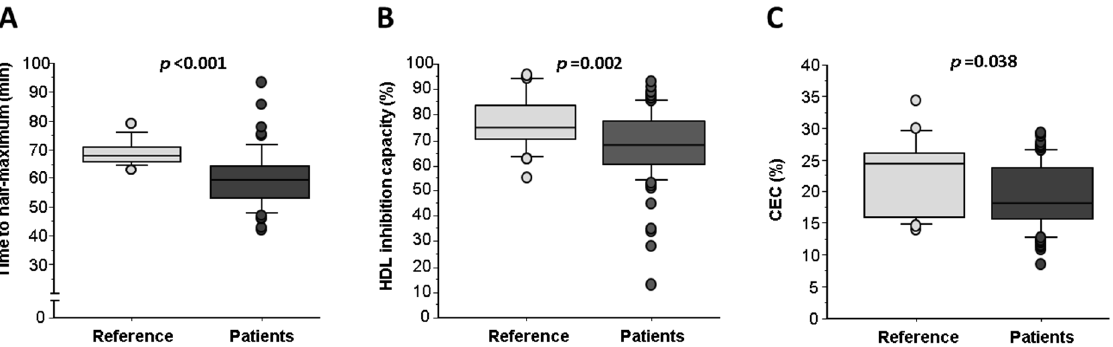
Figure 1. Lipoprotein functionality in the reference group ( n = 31) vs. patients ( n = 97). ( A ) Time to half-maximum oxidation (minutes). ( B ) HDL inhibition of oxidation (%) and ( C ) cholesterol efflux capacity (CEC [%]). Results are expressed as median and quartile 1–3 range (horizontal lines). Student’s t -test values of p < 0.05 for independent samples are considered significant.